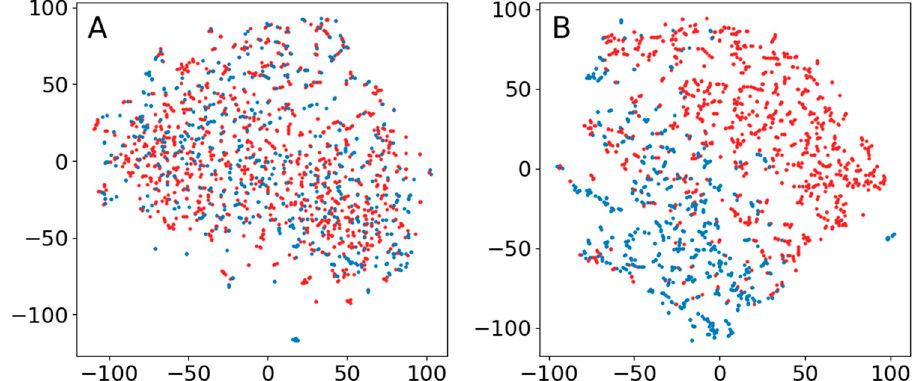
Figure A14. Results of t-SNE with perplexity 0.25% for an EEG representing status epilepticus. Each dot represents 1 s and red dots indicate seizure activity. ( A ) The Daubechies wavelet (db4) using six levels. ( B ) The Ricker wavelet with widths of 2, 3, 4, …, 30.